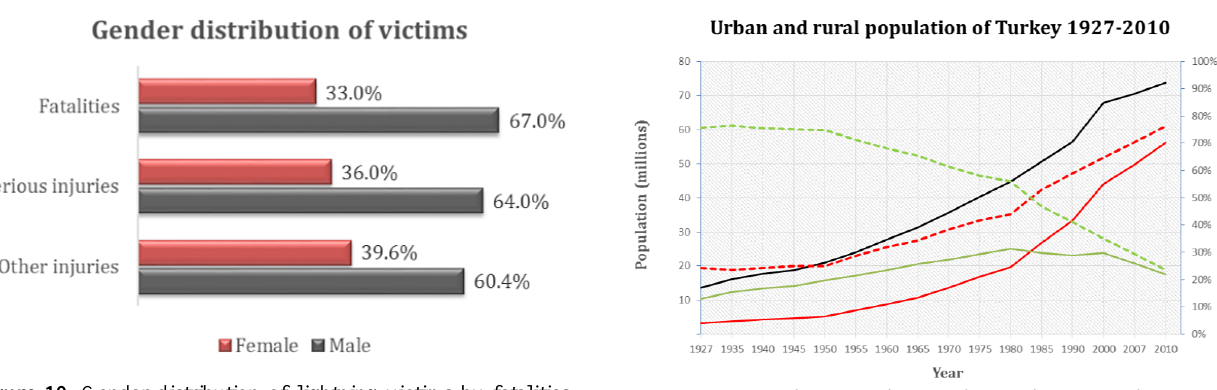
Figure 10. Gender distribution of lightning victims by fatalities, serious injuries, and other injuries (January 1930 to June 2014).